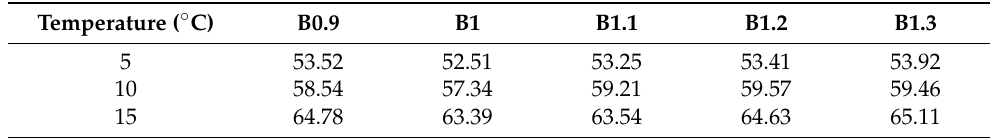
Table 5. Neutron shielding rate of the samples with different formulations treated at 1100 ◦ C for 3 h, whose thicknesses were 5, 10, and 15 mm,